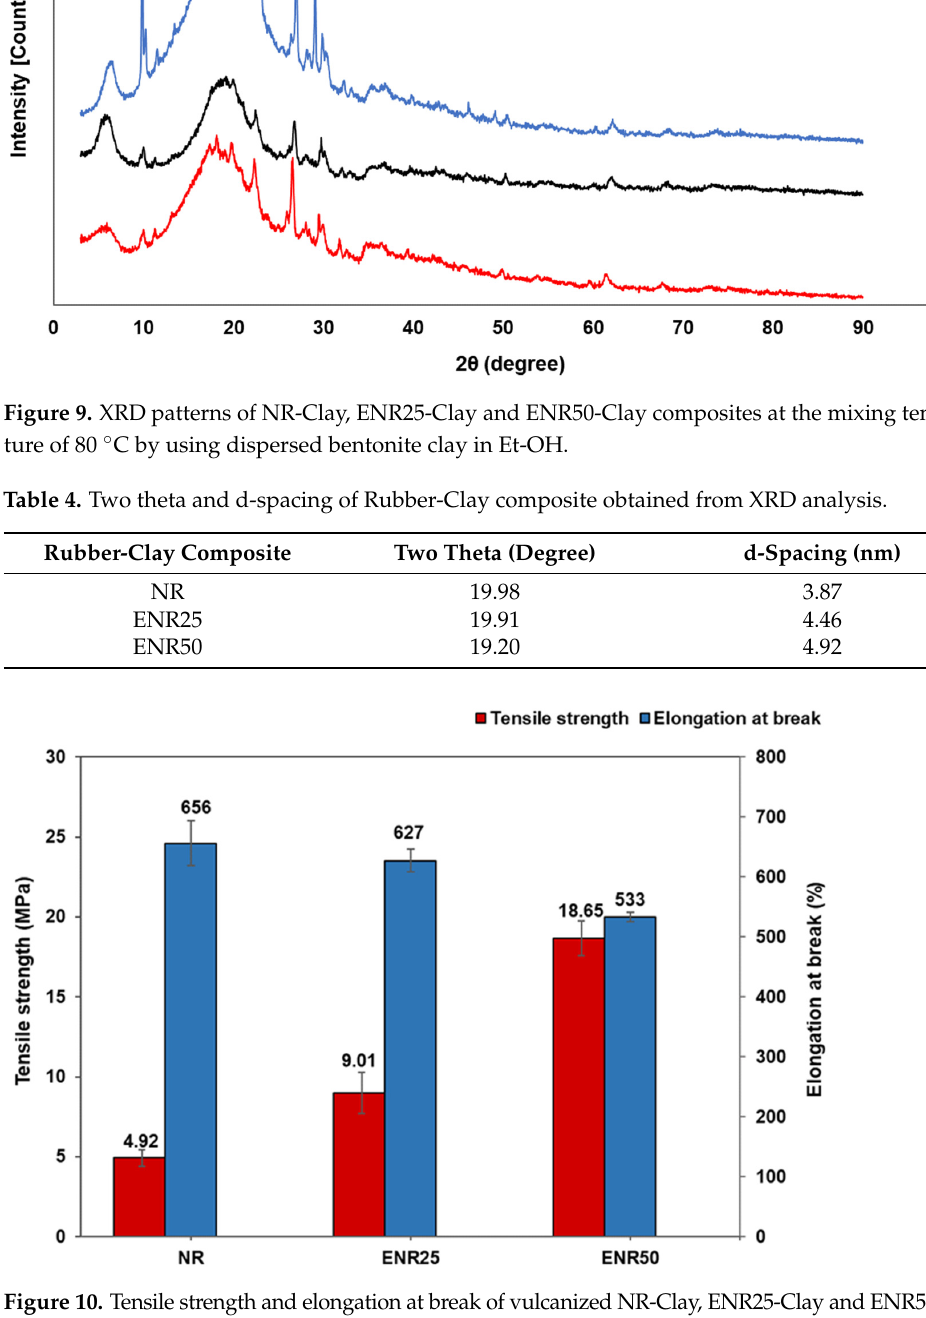
Figure 10. Tensile strength and elongation at break of vulcanized NR-Clay, ENR25-Clay